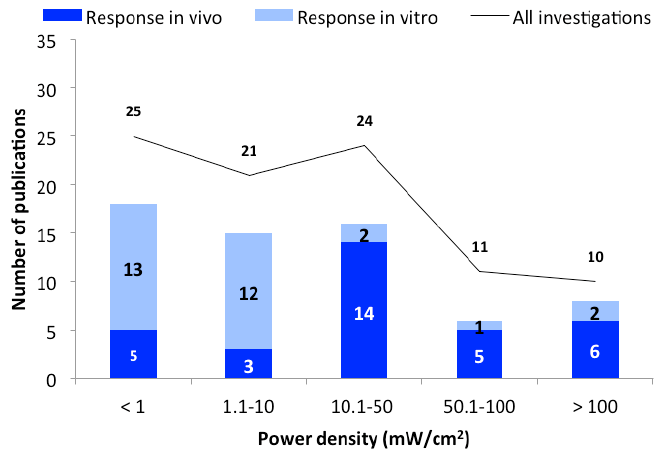
Figure 2. The number of publications as a function of power density. The black line represent the total number of publications, and bars represent the in vivo (dark blue) and in vitro (light blue) studies with biological responses.